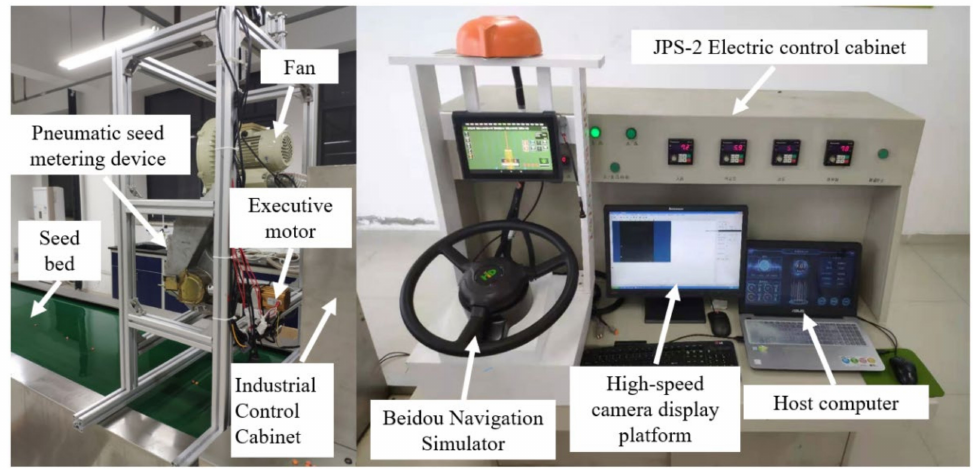
Figure 7. Test bench structure